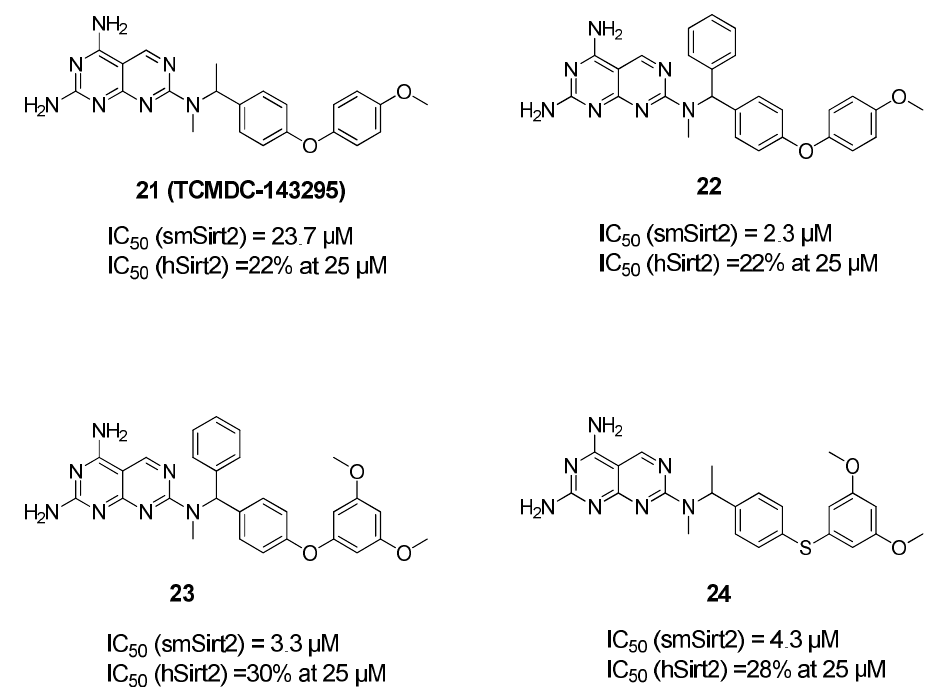
Figure 4. Reported inhibitors of Schistosoma mansoni sirtuins